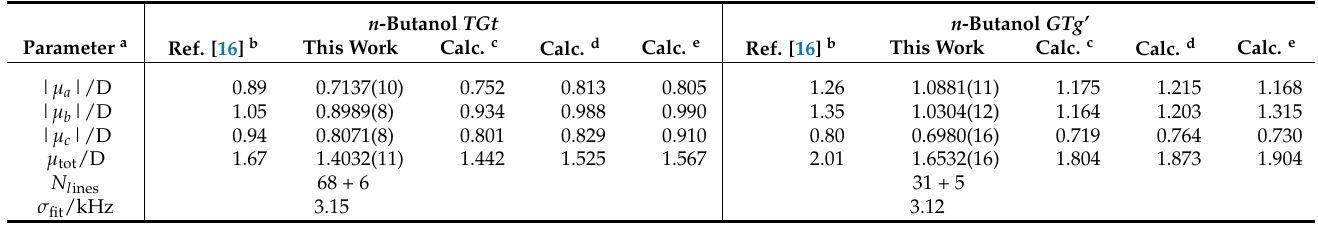
Table 3. Electric dipole moments of the TGt and GTg’ conformers of n -butanol. n -Butanol TGt n -Butanol GTg’ Parameter